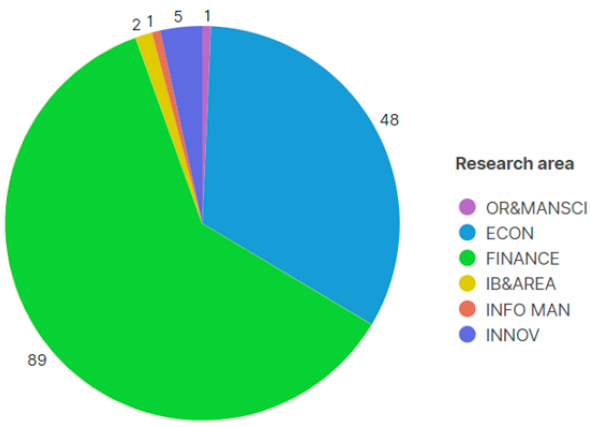
Figure 4. Most productive research areas.